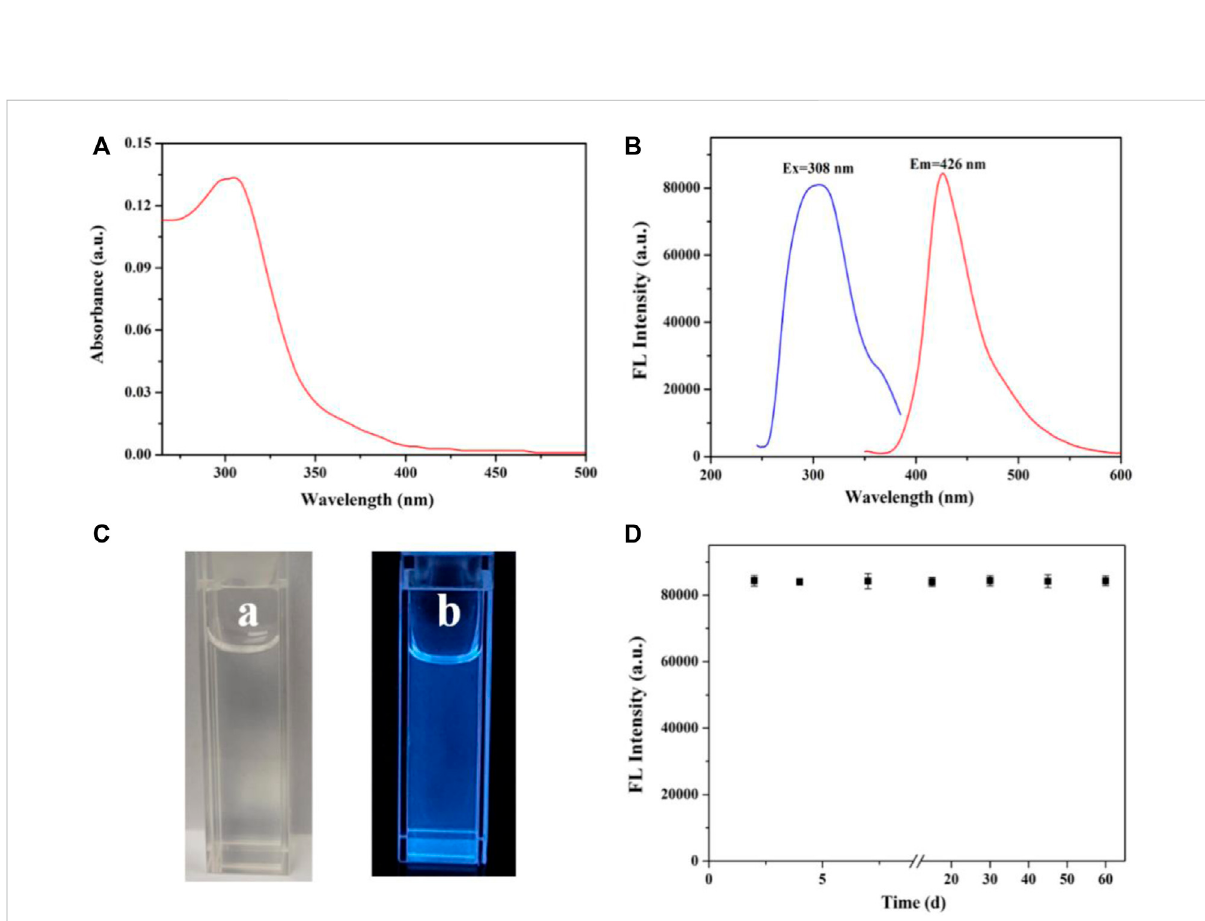
FIGURE 2 (A) UV-Vis spectra of CN NNS; (B) The fl uorescence excitation and emission spectra of CN NNS; (C) The photos of the dispersion under room light (A) and 365 nm UV light (B) ; (D) The fl uorescence photostability of the